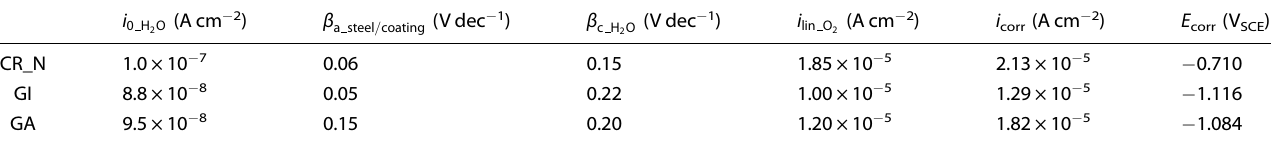
Table 4. Various corrosion parameter values obtained by numerical curve- fi tting to potentiodynamic polarization data of the tested